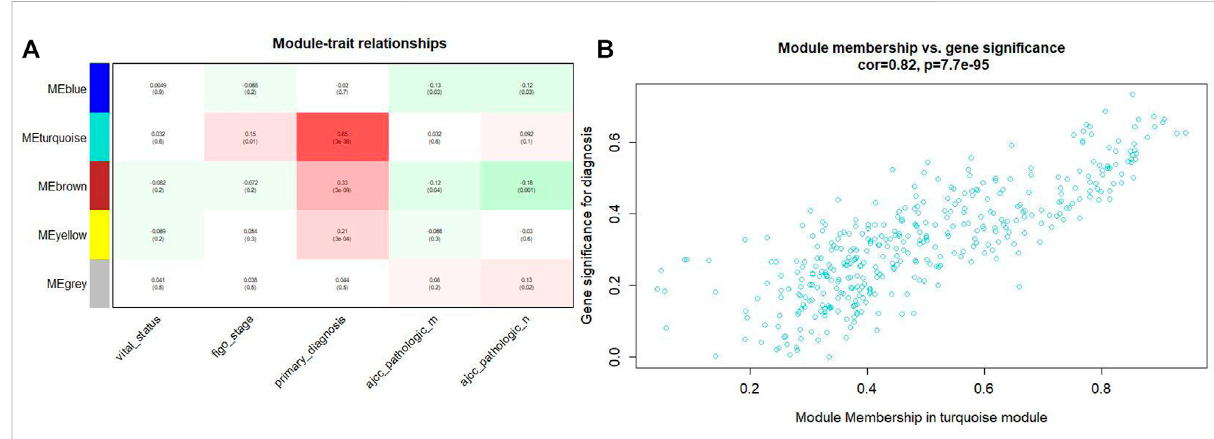
FIGURE4 (A) Relationshipbetweenthemoduletraitsandthemodulesigni fi cance. (B) Theturquoisemodulehasthehighestcorrelationwiththediagnosis level ( p = 0.82, p = 0.65 × 3e-38).